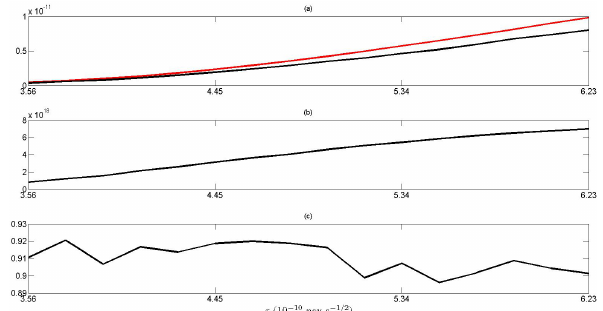
Fig. 2. One-dimensional adimensional potential U(q) obtained as minus the logarithm of the pdf given in Fig. 1.